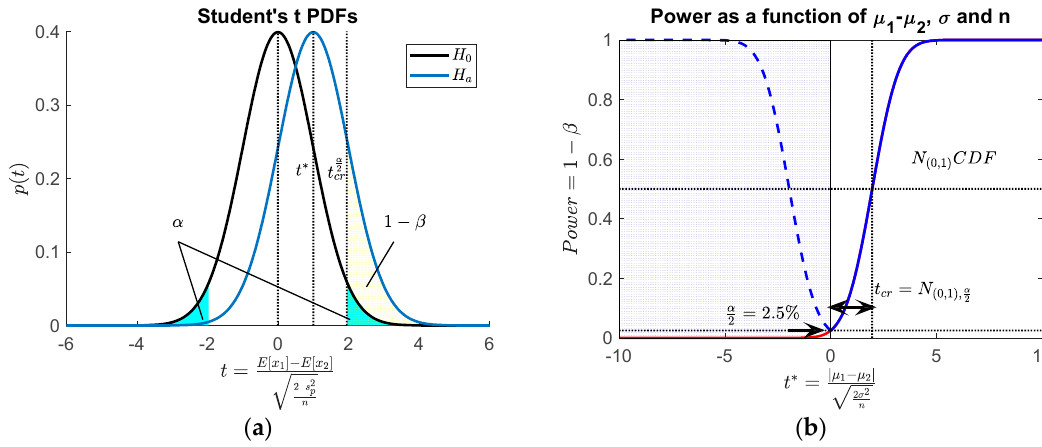
Figure 6. The power of a two population means test—( a ) a visualization of the significance α and of the power 1 − β for a particular case—( b ) the power (under assumption of normality) as a function of t ∗ which depends on the effect size (cid:3091) (cid:3117) (cid:2879)(cid:3091) (cid:3118) σ = d and the sample size n .